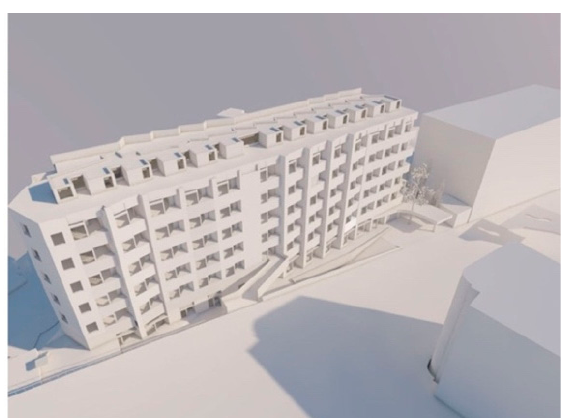
Figure 23. Porto. Model.